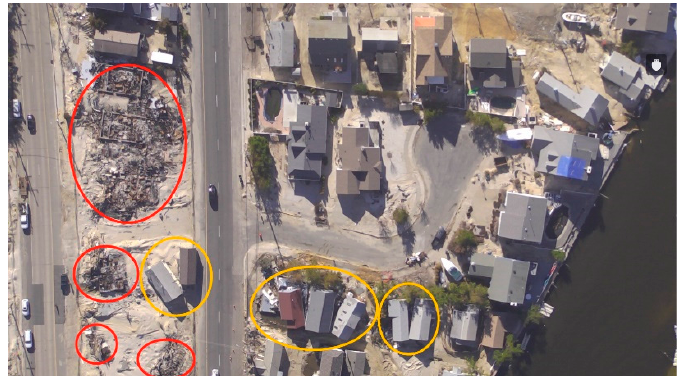
Figure 1. Damage examples. An example aerial image of an aerial image of the impacted area. The red circles highlight the ruins of destroyed houses, and the yellow circles highlight the houses that were displaced or slightly damaged by the hurricane.